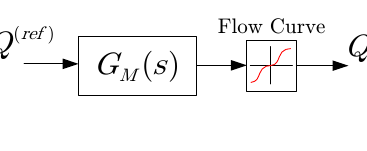
Figure 17: Model structure.